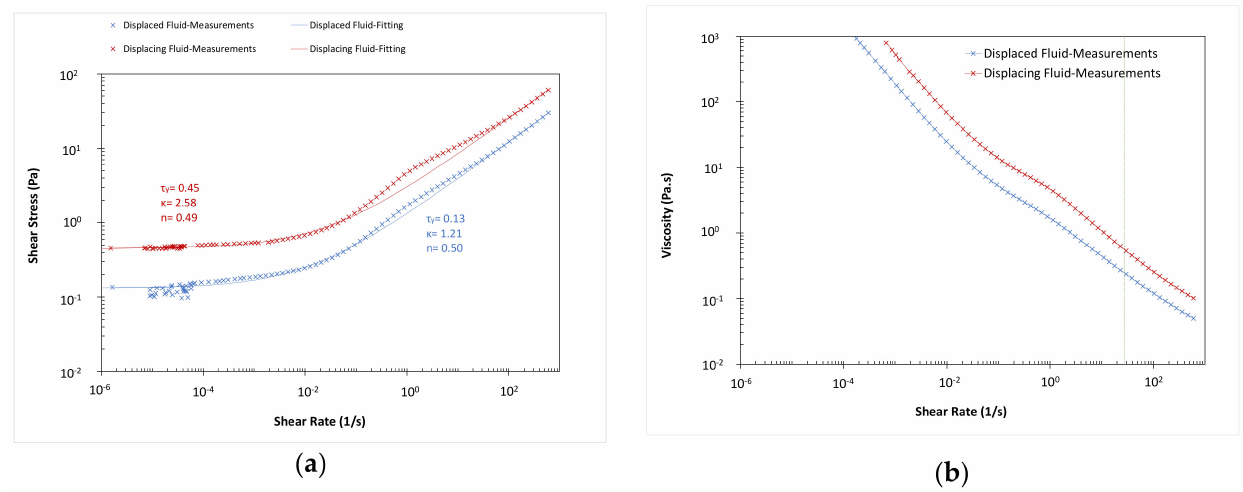
Figure 14. Rheological behavior of the displaced and displacing fluids in test no. 9. ( a ) Flow curve; ( b ) equivalent